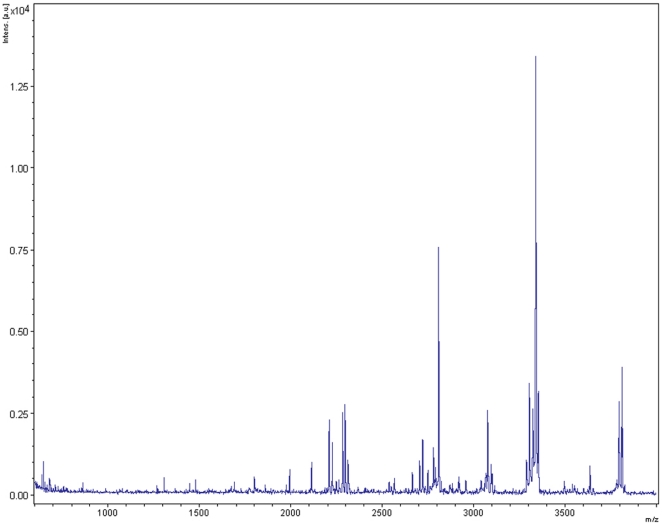
MALDI-TOF MS peptide spectrum obtained from 8,500-year-old human dental pulp.